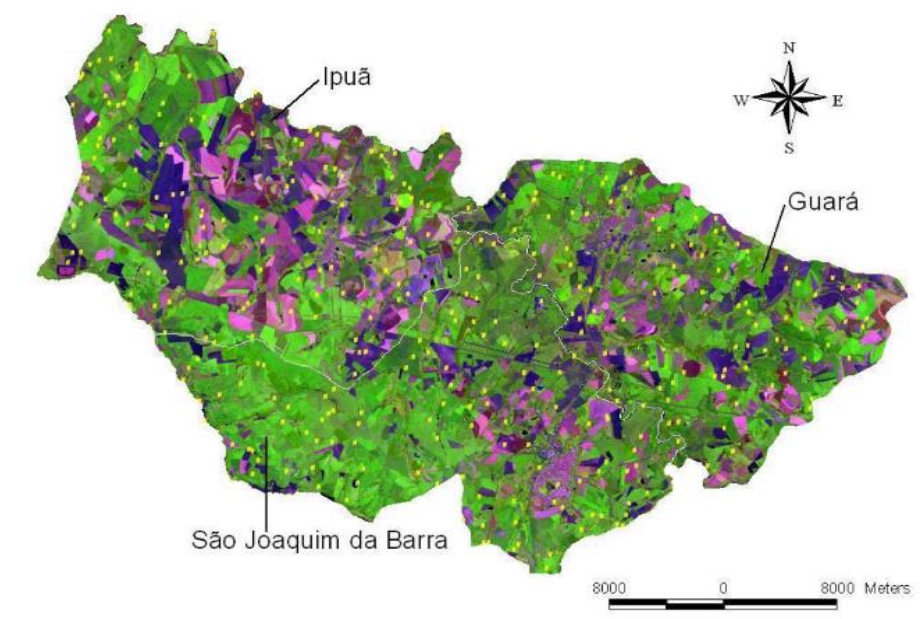
Figure 3: Study area in São Paulo, Brazil (taken from Leite et al.,